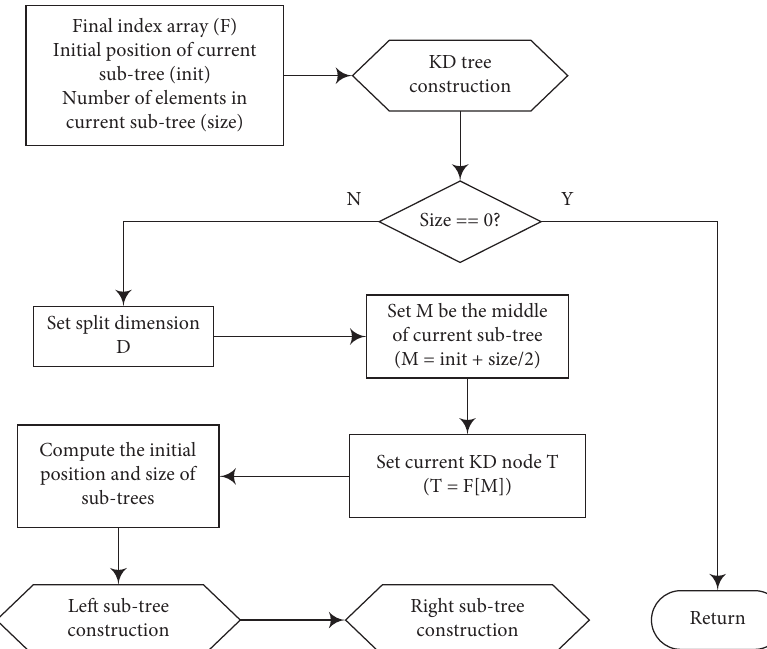
Figure 3: Building a KD tree recursively according to the final index array.